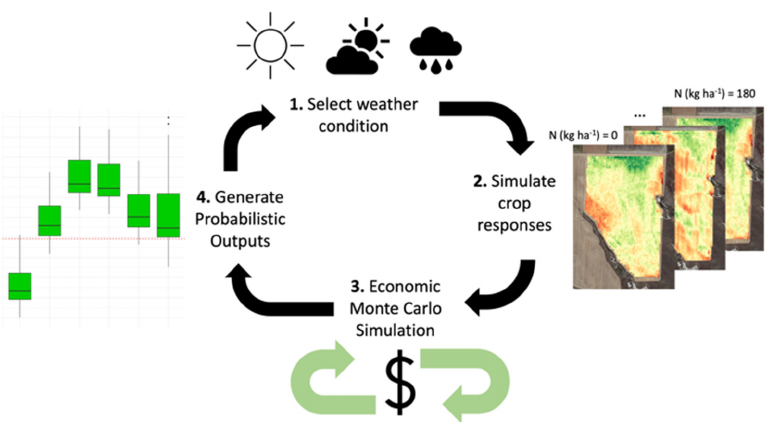
Figure 3. Overview of the OFPE methodology simulation and optimization process. Simulations use the historic local performance of fields to assess the potential for variation in the efficacy of management strategies using a probabilistic format. Simulations begin with the selection of possible weather conditions, typically as a selection from a past weather year (1). Then, the data from that year are used to predict crop responses at every location in the field for a range of agronomic input rates, for example nitrogen fertilizer (2). The OFPE methodology used a bootstrap Monte Carlo sim-